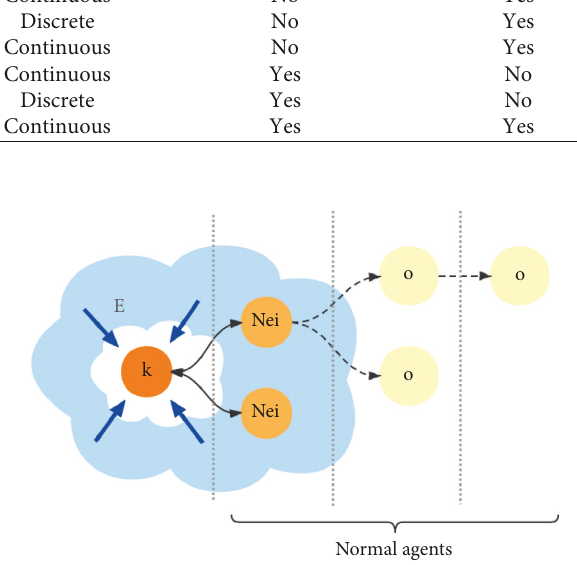
Figure 1: Information wide spreading process. (The node K represents key agents, the node Nei represents neighbour agents, the node O represents other agents, and the arrows show the di- rection of opinion